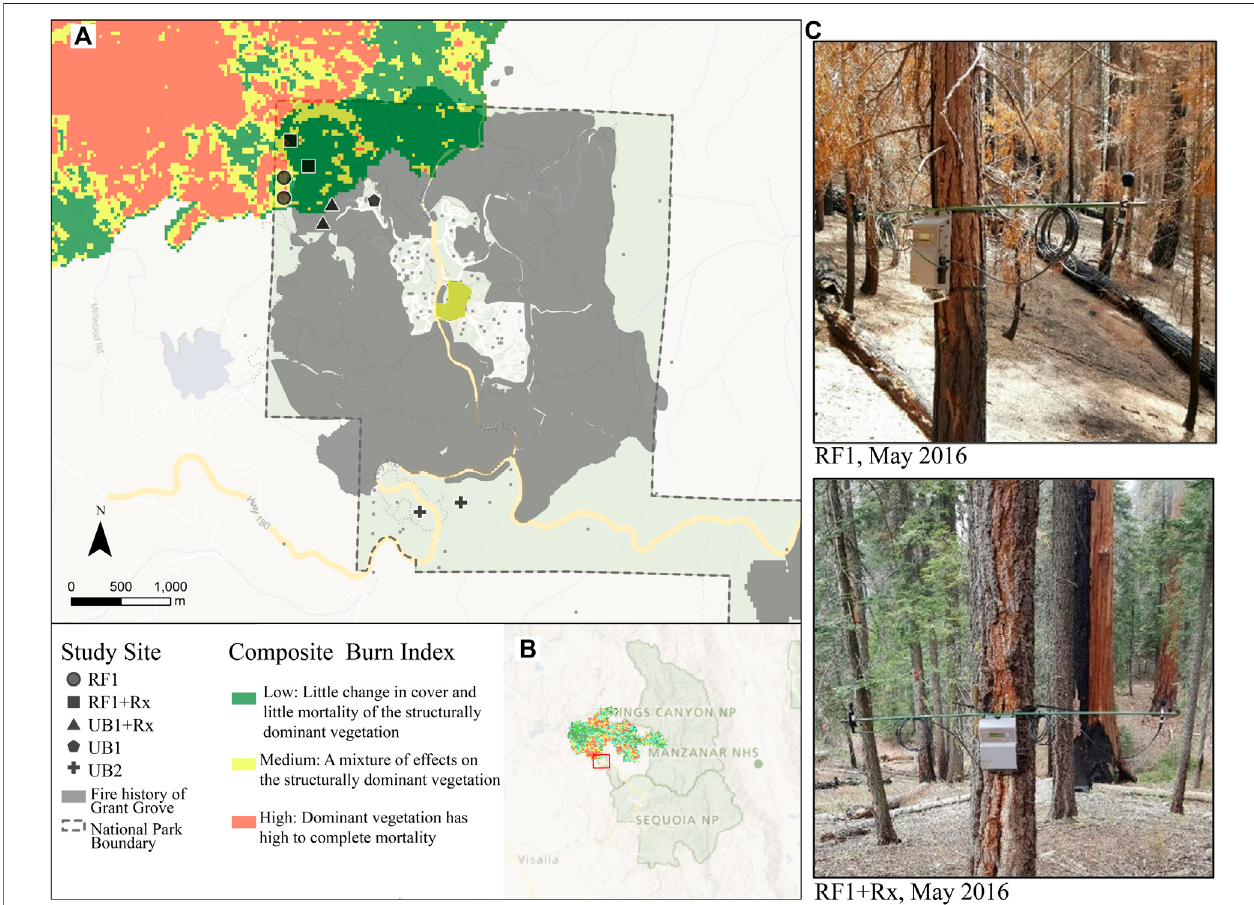
FIGURE 1 | Map of the study region in the Grant Grove region of Sequoia and Kings Canyon National Parks, California (A) , including study sites, prior fi re history, and the 2015 Rough Fire perimeter and fi re severity indices. (B) The greater study area, with the Rough Fire perimeter and fi re severity indices shown. The Composite Burn Index (CBI) is a standardized fi re severity rating based on a composite of effects to the understory vegetation (grass, shrub layers), midstory trees and overstory trees. Raster data were acquired from Forest Service data repository (USFS, 2015). (C) Photographs of two of the nine acoustic monitoring sites in May 2016 (six mountsafterRoughFirewascontained).Acousticrecorders(SongMeter3,WildlifeAcousticInc.)wereattachedtothetreeswithmicrophonesextending0.5 mfromthe recorder. RF1 = Rough Fire without prior prescribed burns. RF1 + Rx = Rough Fire with prior prescribed burns ( Table 1 for descriptions).